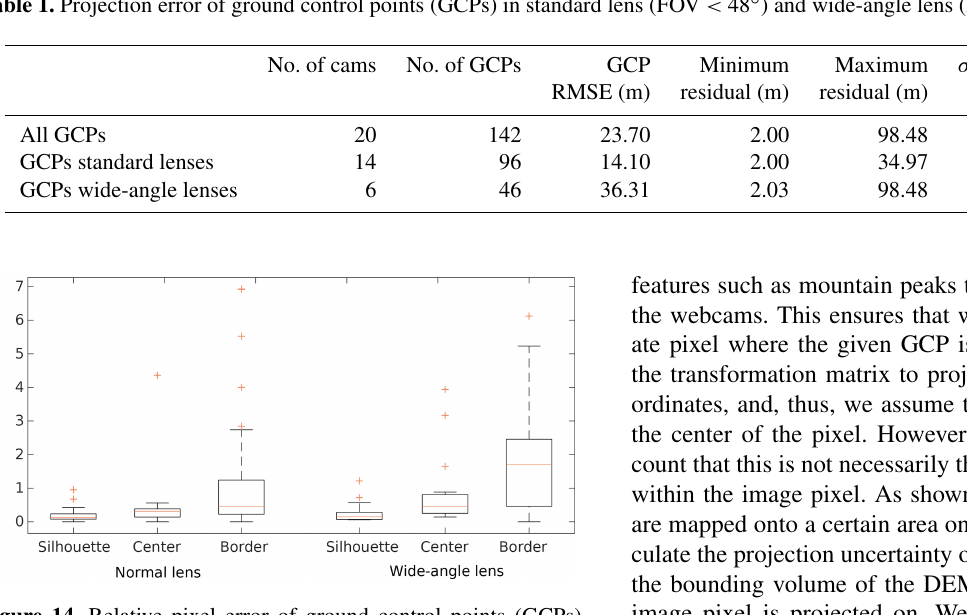
Figure 14. Relative pixel error of ground control points (GCPs) of standard and wide-angle lens webcams. Results are grouped in GCPs located at the mountain silhouette, the center region of the image, and the border region of the image (the outer 25% of the total image width and